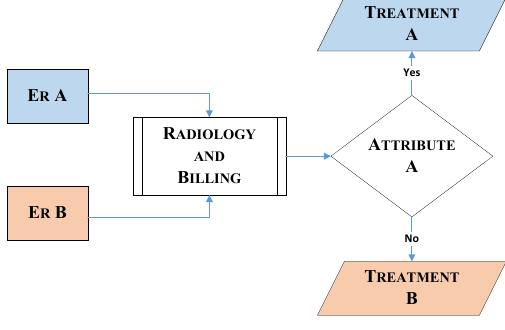
Figure 9. Petri net model